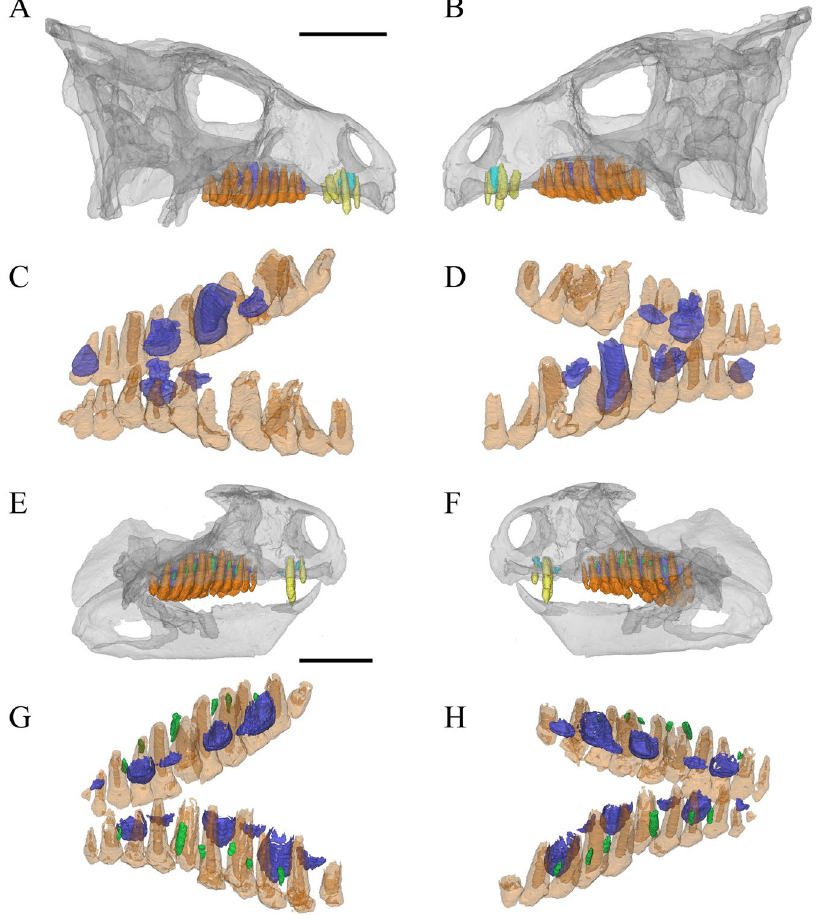
Figure 3. Liaoceratops yanzigouensis , IVPP V12633 and CAGS-IG-VD-002 maxillary teeth. Elements in the CT reconstructions are colour-coded as follows: functional premaxillary teeth, yellow; replacement premaxillary teeth, cyan; remnants of mostly resorbed functional premaxillary teeth, magenta; functional teeth, orange; replacement teeth, blue; resorbed functional teeth, green. ( A , B ) transparent reconstruction of the skull of IVPP V12633 in lateral view; ( C , D ) reconstructed and extracted maxillary teeth composite in dorsal-labial view; ( E , F ) transparent reconstruction of the skull of CAGS-IG-VD-002 in lateral view; ( G , H ) reconstructed and extracted maxillary teeth composite of CAGS-IG-VD-002 in dorsal-labial view. Scale bars equal 20